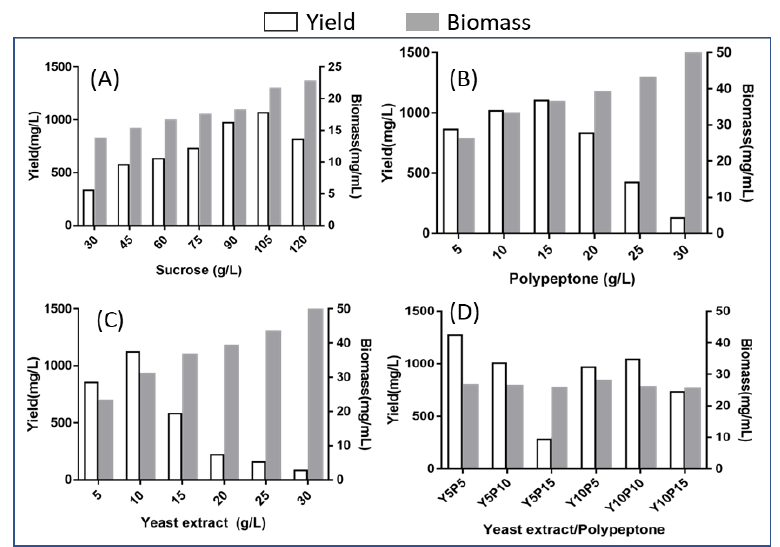
Figure 7. Effect of nutritional factor on balanol production including sucrose ( A ), polypeptone ( B ), yeast extract ( C ) and combined yeast extract and polypeptone ( D ).